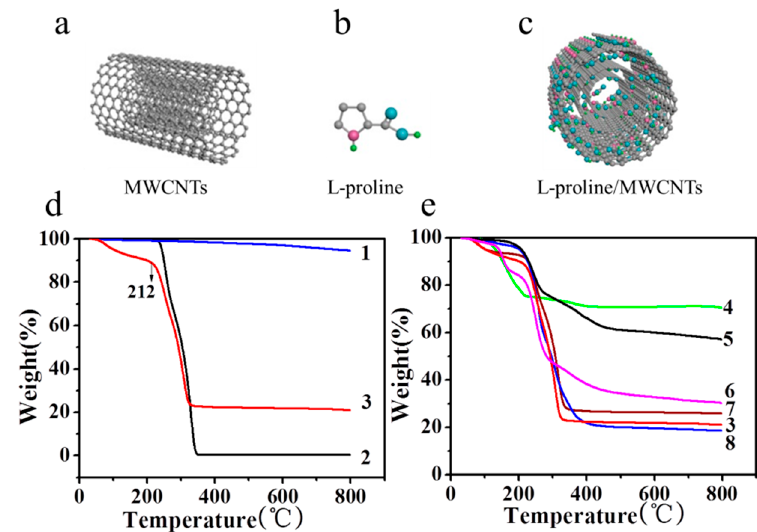
Figure 1. ( a ). MWCNTs, ( b ). neat L-proline, ( c ). L-proline/MWCNTs, ( d ). TGA of (1) MWCNTs, (2) neat L-proline, and (3) L-proline/MWCNTs catalyst after 3 rounds of washing with H 2 O, ( e ). TGA of (4) L-proline/MWCNTs catalyst after additional washing with 10% aq. NaOH, (5) L-proline/SWCNTs catalyst, (6) L-proline/graphene oxide (GO) catalyst after 5 rounds of washing with H 2 O, (7) L-proline/MWCNTs catalyst after 5 rounds of washing with H 2 O, and (8) L-proline/MWCNTs catalyst after additional washing with 10% aq. H 2 SO 4 .